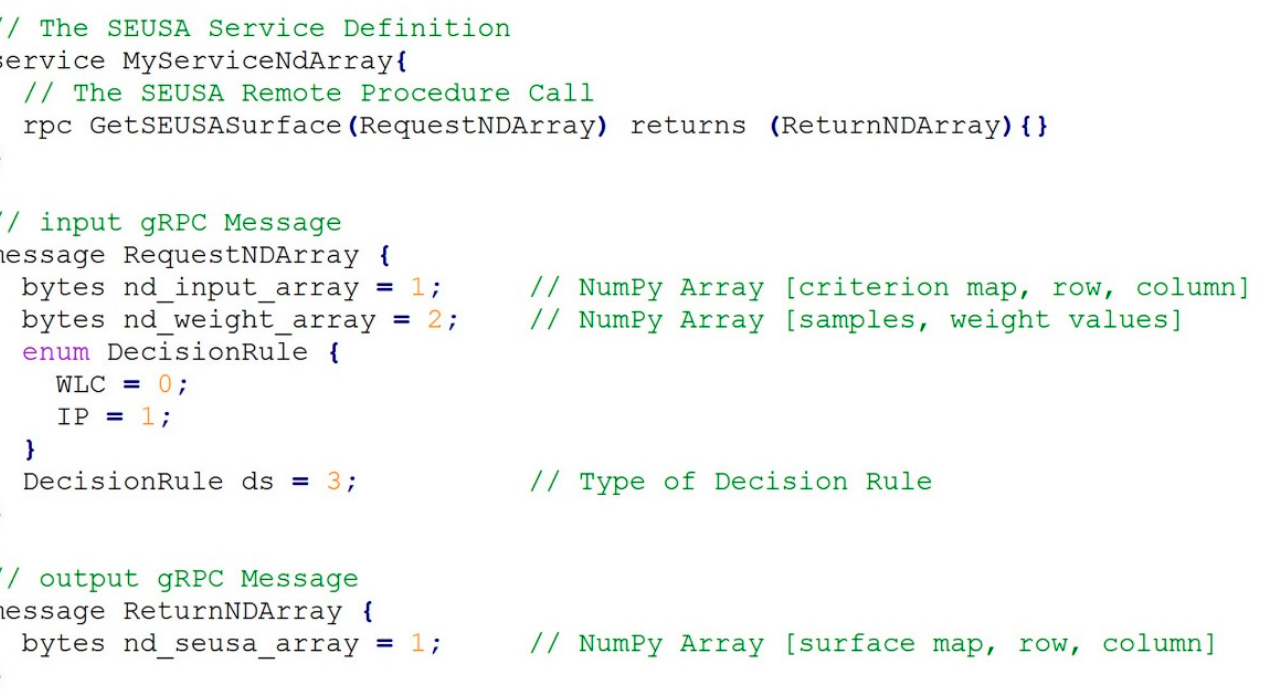
Figure 3. The proto file. A simple SEUSA proto example.